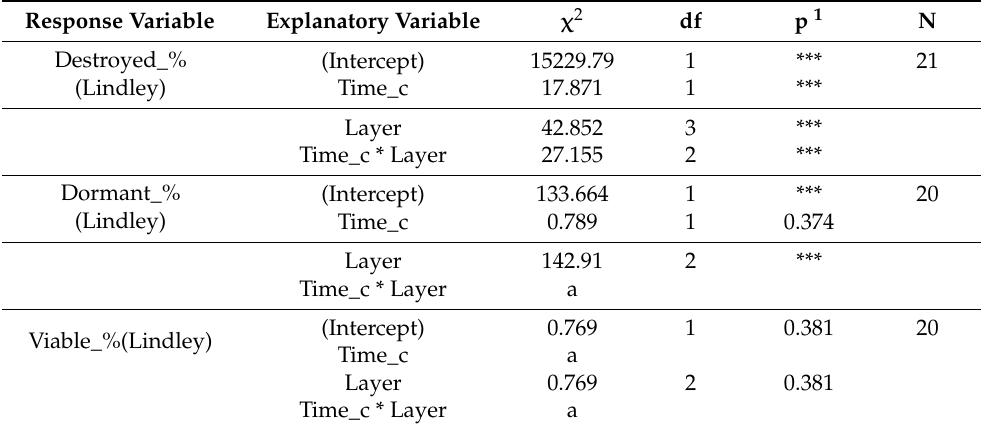
Table 3. Results from generalized linear mixed models used to determine the effects time, temperature and layer in the biomass on the proportion of destroyed, dormant and viable L. polyphyllus Lindl. seed after farm-scale AD process.